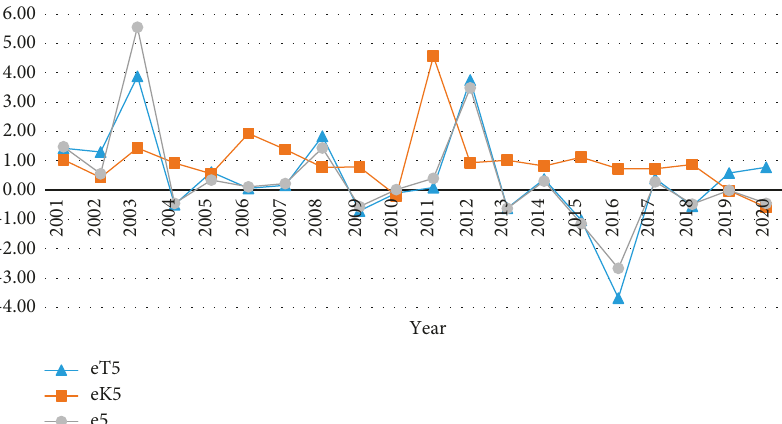
Figure 22: Relationship between carbon emission decoupling index and intermediate variables of the nonmetallic sector from 2001 to